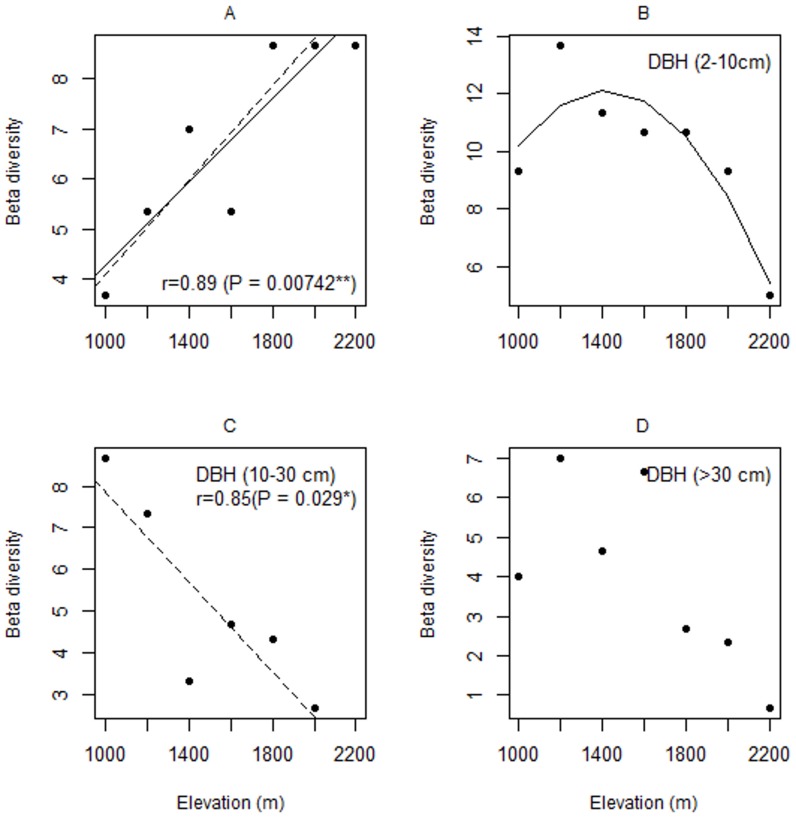
Relationships between elevation and beta-diversity (among plots with elevation stations) for different components of vegetation on Mount Rinjani, Indonesia.(A) ground-cover plants (y = 6.92+2.06x), (B) understorey plants (y = 10-4.2x-4.04x2, all stations 2200 m included), (C) subcanopy plants (y = 4.62-2.32x), (D) canopy plants. Solid lines indicate relationships including all elevation stations and the dashed lines indicate the relationships when the station at 2200 m (fire-maintained grassland) was omitted. Only relationships that were significant (p<0.05) in univariate regression models are shown.